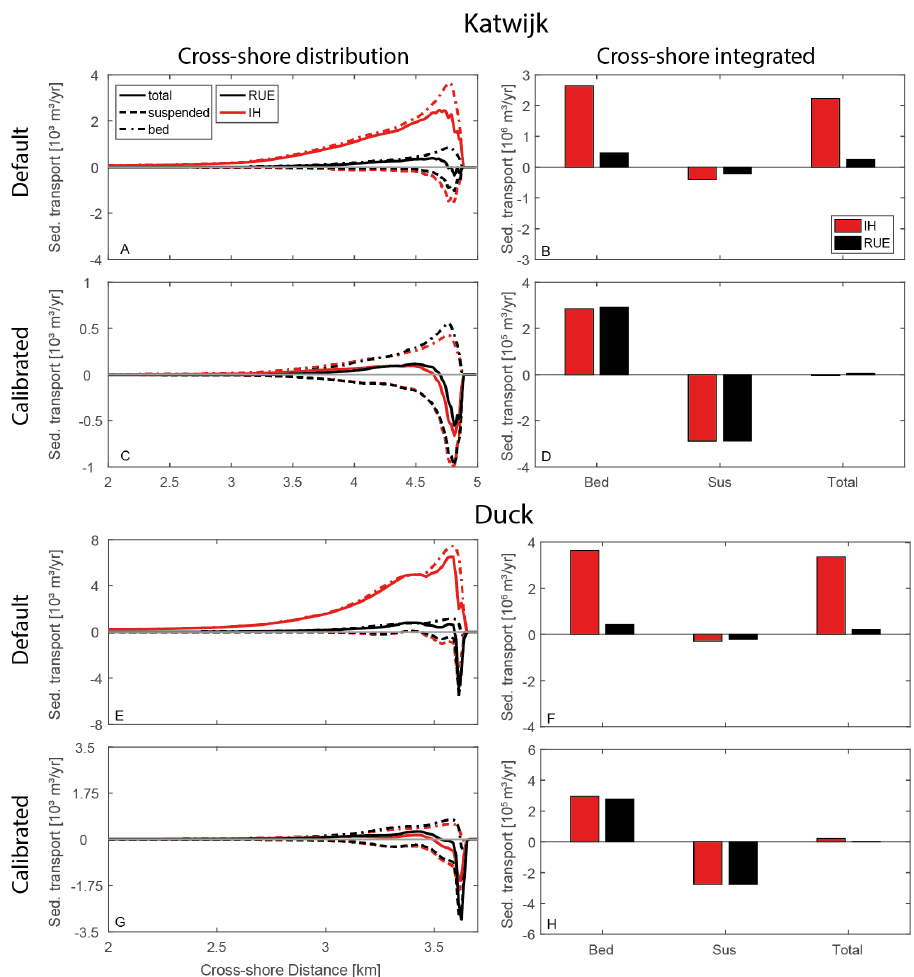
Figure 6. Annual cross-shore sediment transport at Katwijk ( A – D ) and Duck ( E – H ). Positive values are onshore-directed. IH and RUE are color-coded with red and black. Note the difference in vertical axis scale between plots. ( A , C , E , G ) shows the cross-shore profile of sediment transport and ( B , D , F , H ) integrates the values in the cross-shore direction. Panels ( A , B , E , F ) shows sediment transport values for default sediment transport factors and panels ( C , D , G , H ) after calibration is applied (see Table 3). Table 3. Sediment transport calibration factors for Katwijk and Duck for IH and RUE formulation. w stands for wave-related; c for current-related; b for bed load; and s for suspended load. Calibration